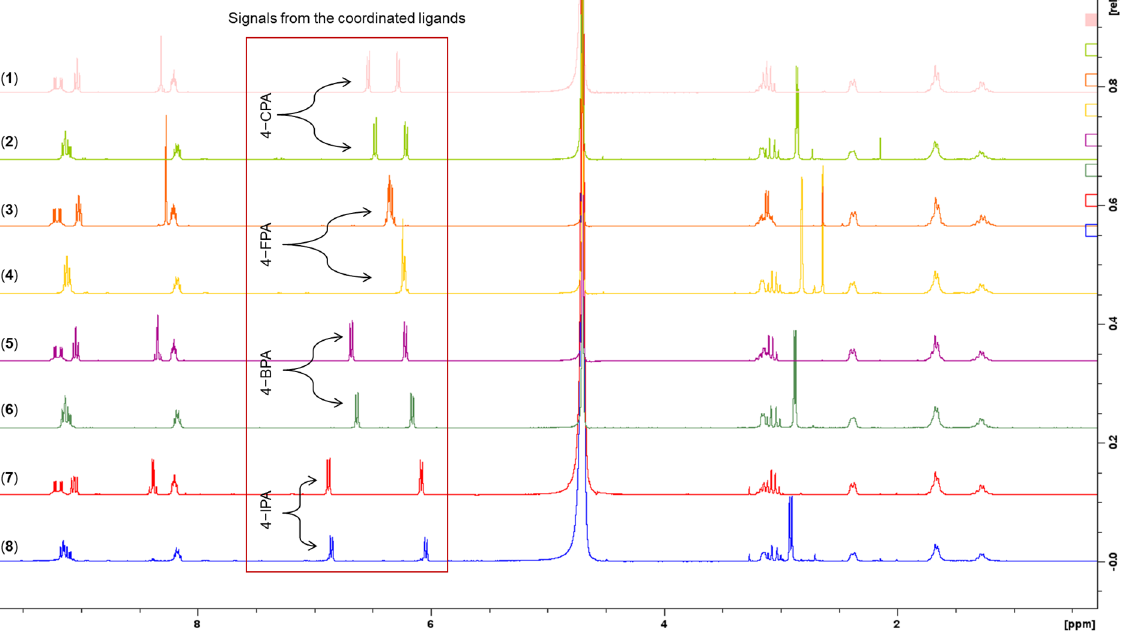
Table 3. Band maxima in the UV and CD spectra of 1 – 8 .